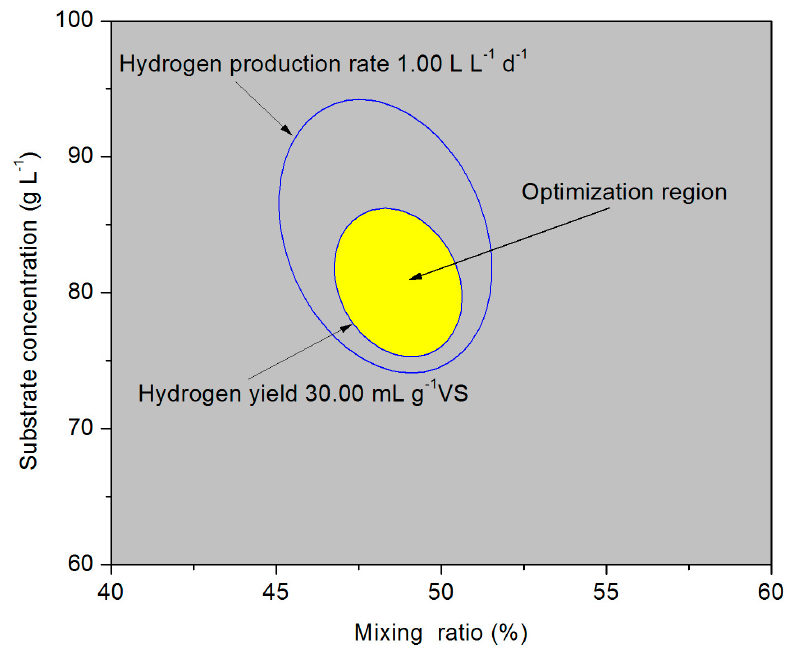
Figure 4. Process optimization (the hydraulic retention time is 2 d).